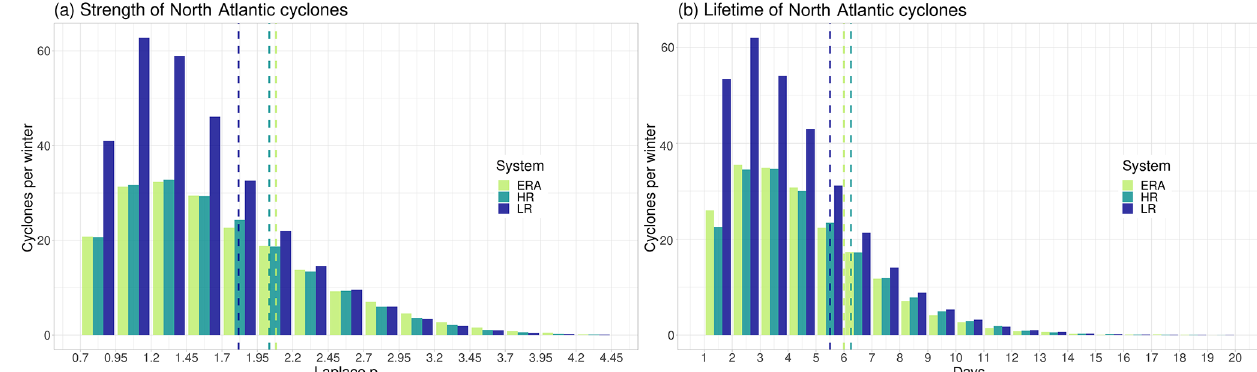
Figure 4. Histograms of (a) the strength (max. along-track Laplacian of the sea level pressure in hPa / (degree latitude) 2 ) and (b) the lifetime (in days) of cyclones that pass the central North Atlantic (50–10 ◦ W, 40–60 ◦ N) at any time during their existence. For the hindcasts individual cyclone tracks of all five members and lead winters 2–5 of the initializations 1978–2012 are used, and for ERA-Interim individual cyclone tracks of the period 1979/80 to 2016/17 are used. Vertical dashed lines denote the 0.75 quantile, i.e., the 25% strongest and longest-lived cyclones of each